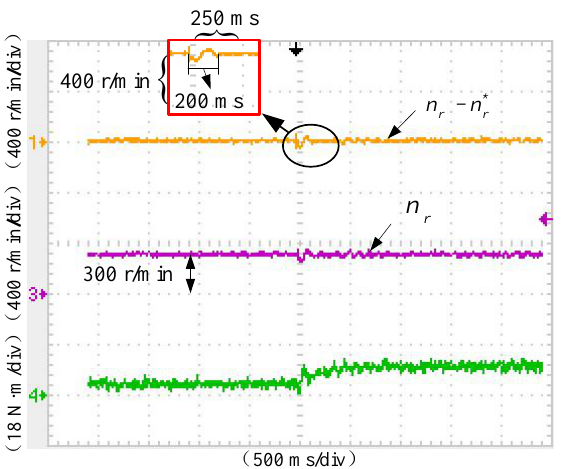
Figure 23. Experimental results of DTC ( P = 10, I = 1.2).